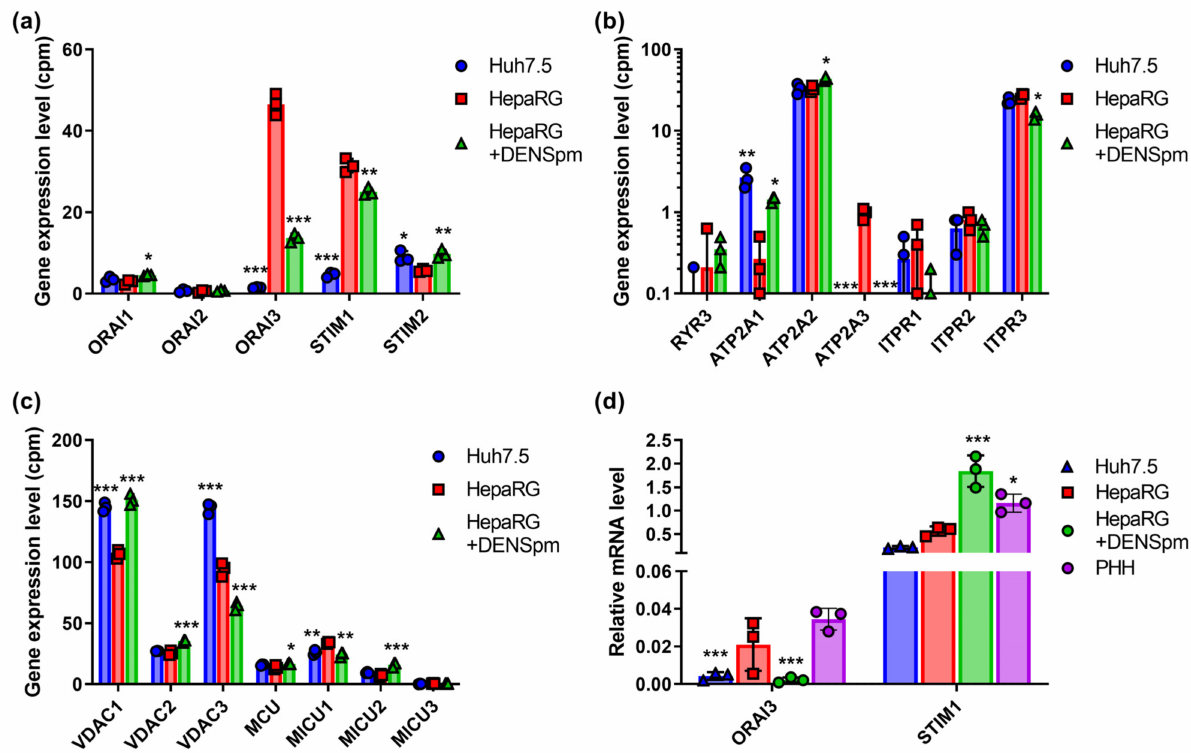
Figure 6. Relative mRNA levels of the genes of calcium homeostasis in hepatoma Huh7.5 cells, hepatocyte-like HepaRG cells, and HepaRG cells treated with DENSpm, assessed by RNAseq analysis. Levels of mRNA of plasmatic calcium transporters and auxiliary proteins ( a ), ER calcium pumps ( b ), or of mitochondrial transporters ( c ). ( d ) Relative levels of ORAI3 and STIM1 mRNA in these cells and PHH assessed by RT-qPCR and normalized to the levels of GUS mRNA. Bars are means ± S.D. Statistical significance was analyzed by ANOVA using Tukey’s post hoc test. Statistical significance is presented for the comparison of cells to the differentiated HepaRG cells. * p < 0.05, ** p < 0.01, *** p <